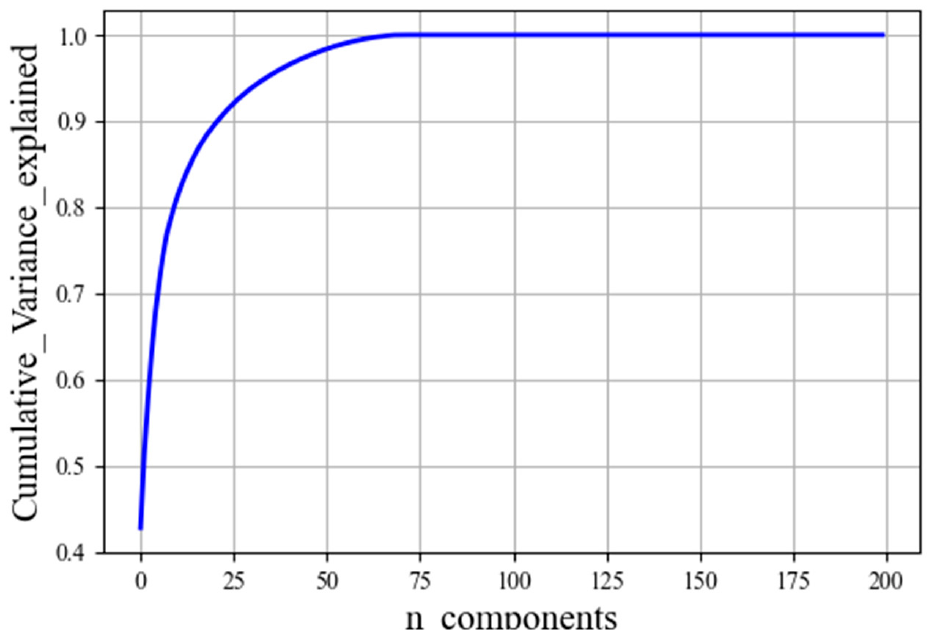
Figure 9. The explained variance for all the components.